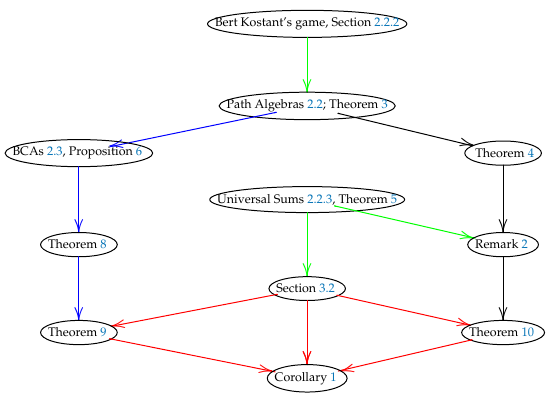
Figure 1. Brauer configuration algebras, Bert Kostant’s game, and mixed sums of square and triangular numbers allow finding main results in this paper. Theorem 9 gives formulas for dimensions of Brauer configuration algebras and corresponding centers associated with the introduced wargame. Such a theorem allows establishing whether a launch of a ground base detector succeeds or fails to detect a missile launched by an adversary using universal sums of triangular numbers. Similar results are given in Theorem 10, but instead of using universal sums of triangular numbers, we use universal sums of square numbers. Corollary 1 applies the Legendre–Gauss theorem on sums of three square numbers to determine which conditions allow an adversary to succeed in the proposed